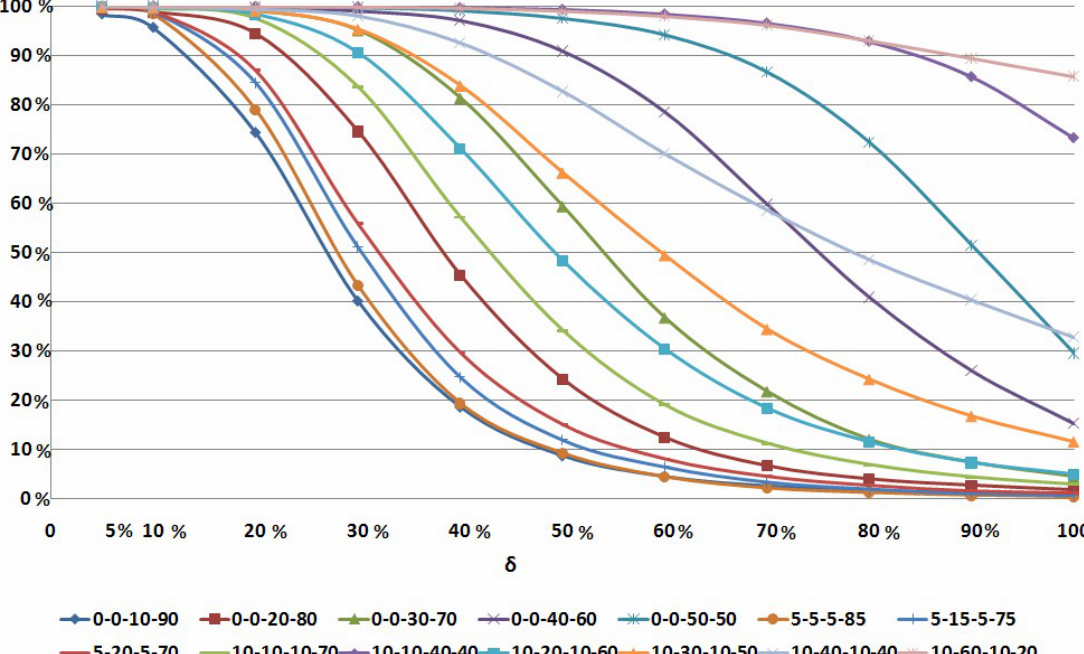
Figure 5. Average percentages of the instances whose optimality of the constructed pair of job permutations was proven at the off-line phase and on-line phase of